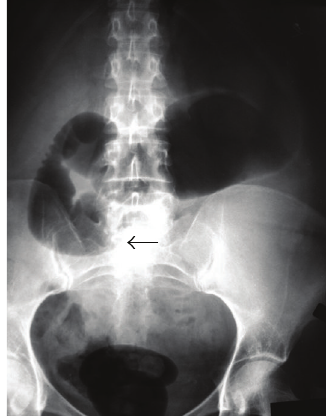
Figure 1: Abdominal X-ray demonstrating abrupt cut o ff sign at the 3rd portion of duodenum. Dilated stomach and proximal duodenum. Black arrow shows the cut-o ff sign.